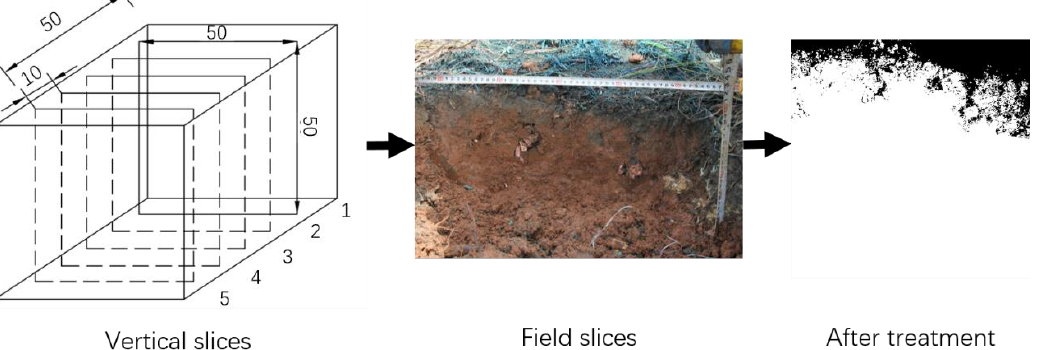
Figure 1. Example of stained profiles (cm) and image processing.